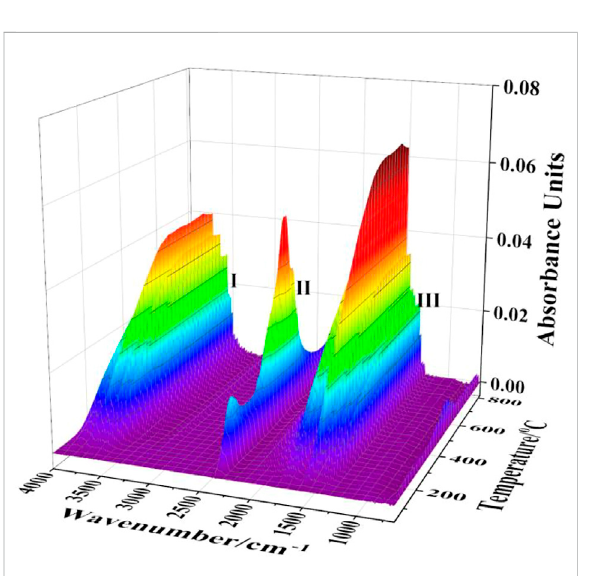
FIGURE 6 Three-dimensional (FTIR) spectra of the gas products.